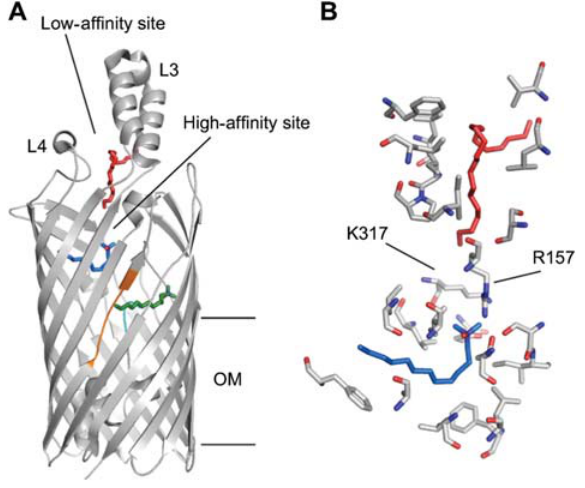
Figure 2 Detergent binding sites in E. coli FadL. (A) Overview showing a C E molecule (red) in the low-affinity 8 4 binding groove between loops L3 and L4, the LDAO molecule in the high-affinity binding pocket (blue), and an LDAO molecule bound in the region of the lateral opening (green). (B) Close-up of the low- and high-affinity binding sites with the residues shown (as stick models, with carbon gray, oxygen red and nitrogen blue) that are 4 A˚ or closer to the detergent molecules. Residues Arg157 and Lys317, probably involved in binding the LCFA carboxyl group, are indicated. The orientation is identical to that in panel (A).